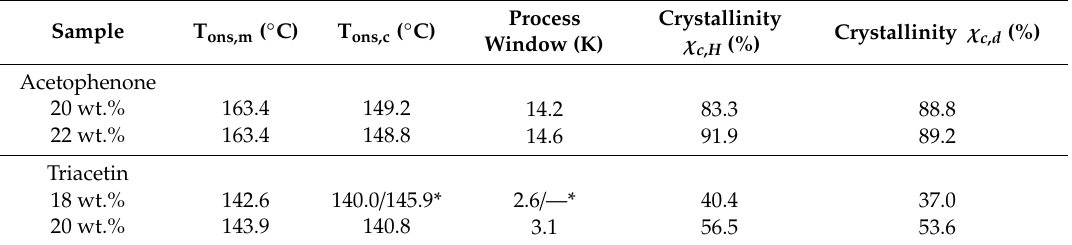
Table 2. Onsets of melting T ons,m and crystallization T ons,c , process window, and degree of crystallinity χ of the investigated POM samples.